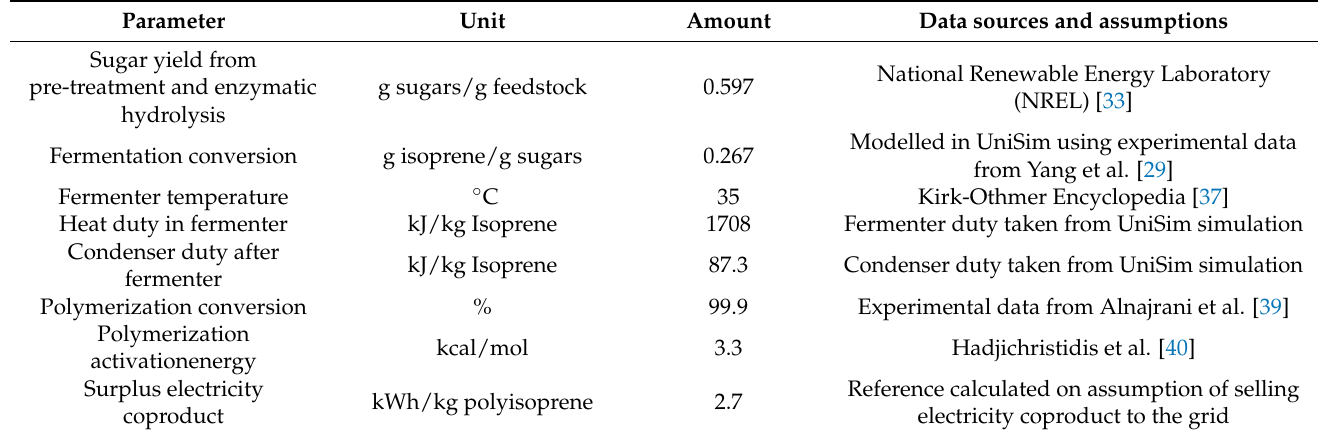
Table 1. Parameter settings for Life Cycle